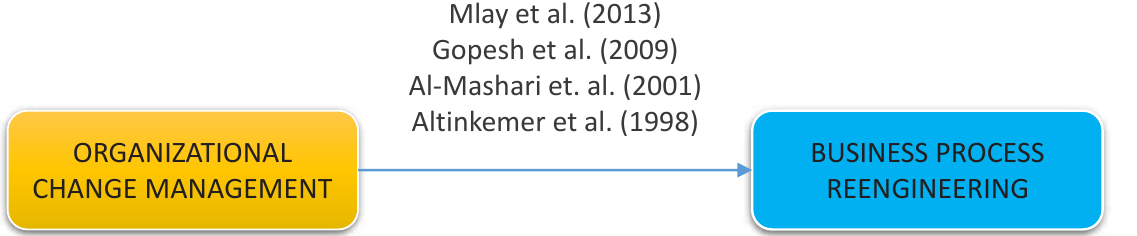
Figure 5. Organizational change management relationship toward business process